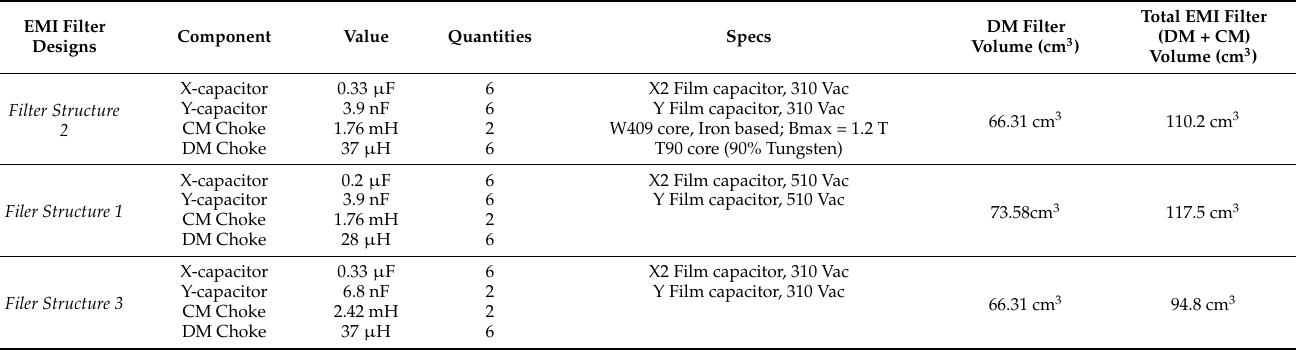
Table 2. Volumetric Comparison of Designed EMI Filter